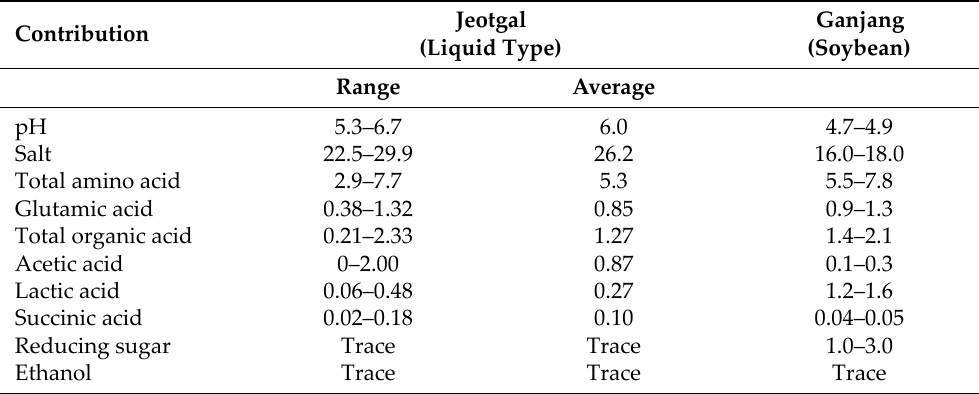
Table 1. Characteristics of jeotgal and ganjang